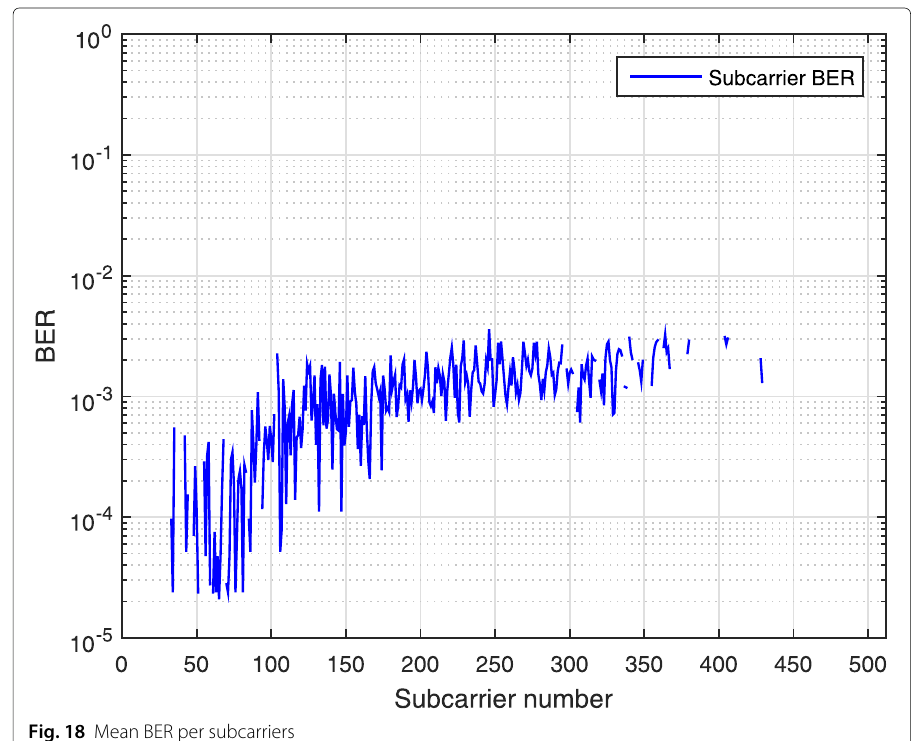
Fig. 18 Mean BER per subcarriers